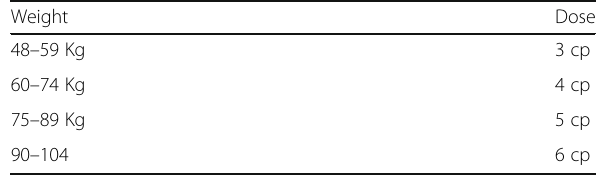
Table 1 Ge-OH administration was twice daily after meals according to the scheme below, based on the subject ’ s weight for a maximum dose of 10 mg Kg ( − 1) die